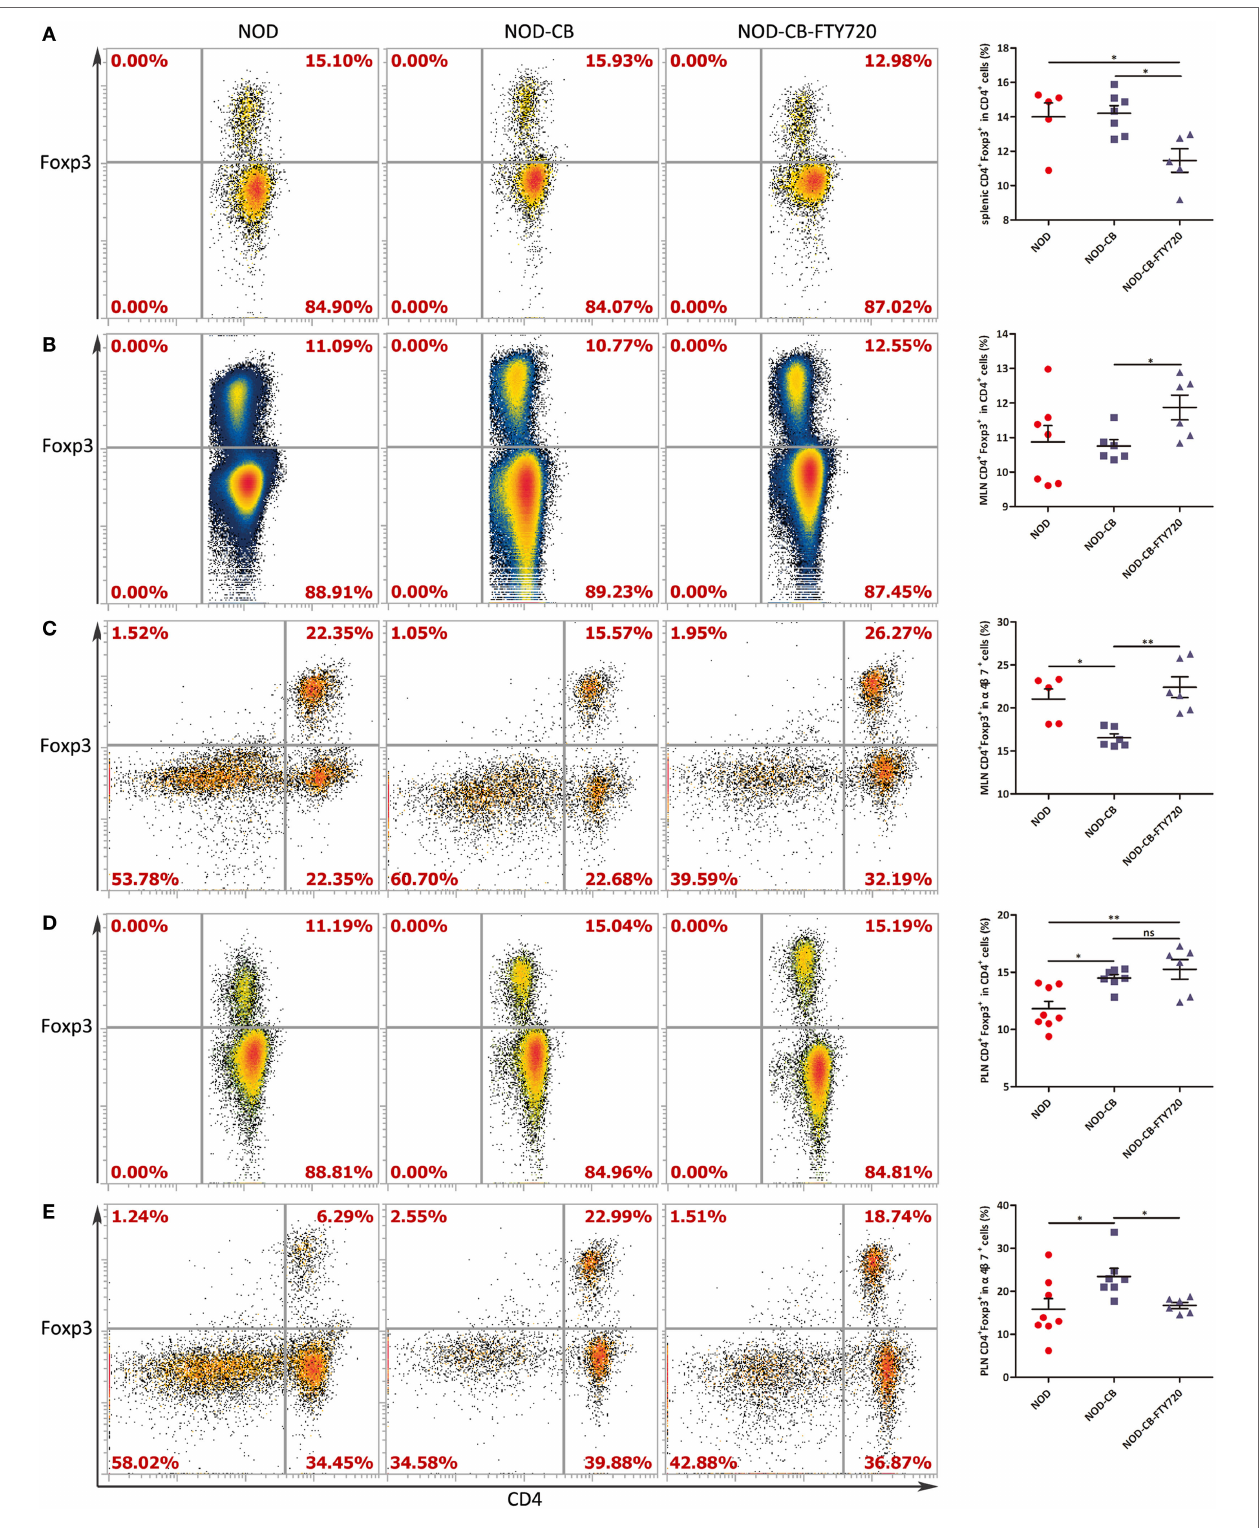
FigUre 7 | FTY720 suppresses the accumulation of α 4 β 7 + Tregs but not the total Tregs in the PLN. (a) Percent CD4 + Foxp3 + in CD4 + spleen cells. (B) Percent CD4 + Foxp3 + in CD4 + MLN cells. (c) Percent CD4 + Foxp3 + in α 4 β 7 + MLN cells. (D) Percent CD4 + Foxp3 + in CD4 + PLN cells. (e) Percent CD4 + Foxp3 + in α 4 β 7 + PLN cells. Data are mean ± SEM ( n = 5–8 mice per group). *, **, *** p < 0.05, p < 0.01, p < 0.001 vs NOD control mice by t -test. The number of cells is 10,000–300,000.